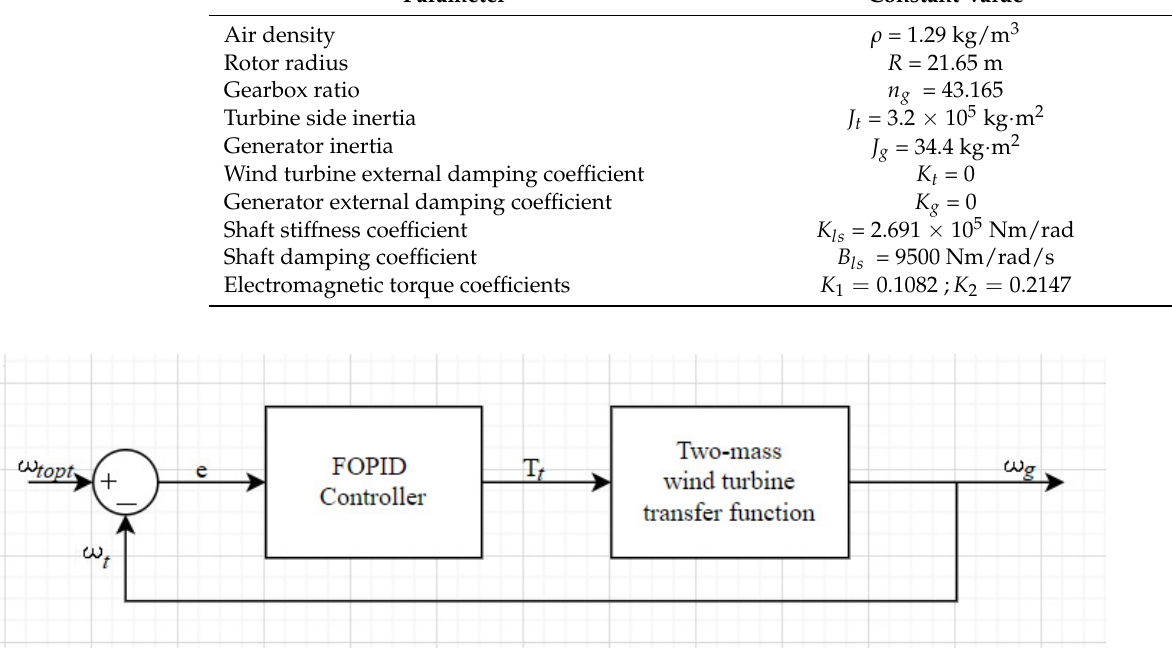
Table 1. The parameters of the two-mass wind turbine mathematical model . Parameter Constant Value Air density Figure 2. A Simulink block diagram of the two-mass wind turbine mathematical model.